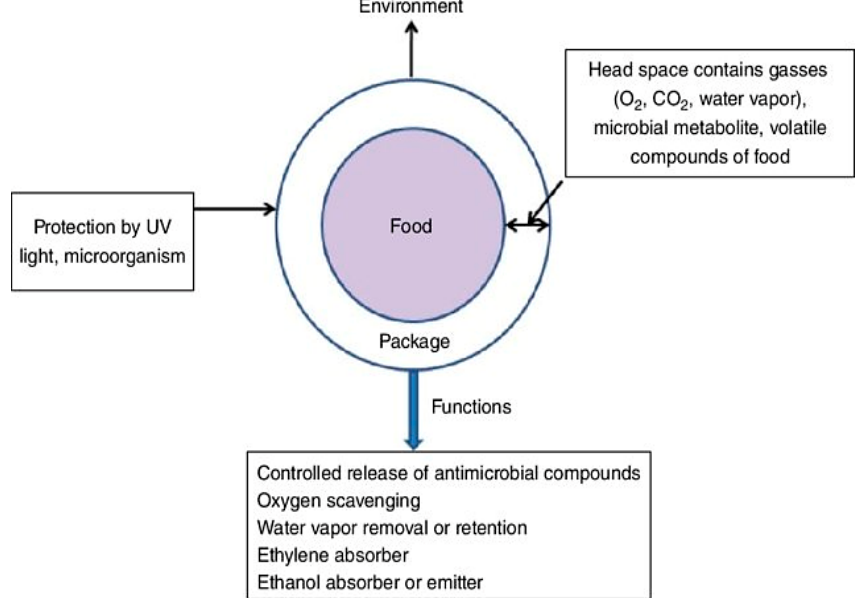
Figure 14. Functions of active packaging to improve self-life of packaged food (taken from